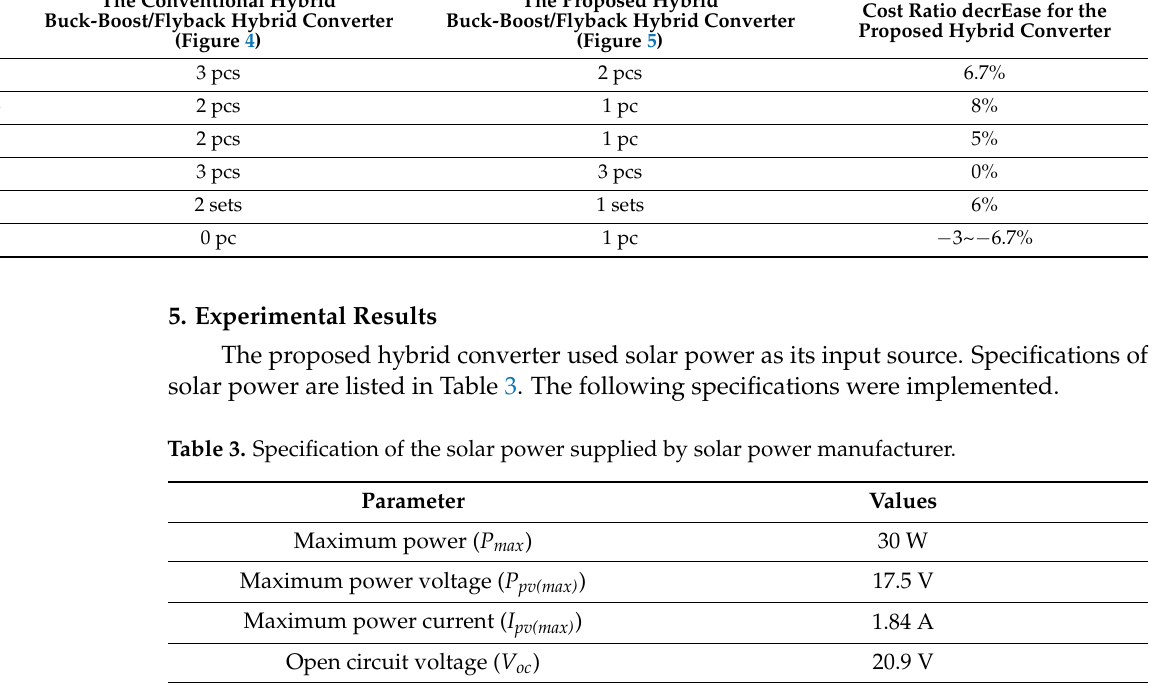
Table 2. Component count comparison between the proposed hybrid converter and the conventional counterpart converter. Component